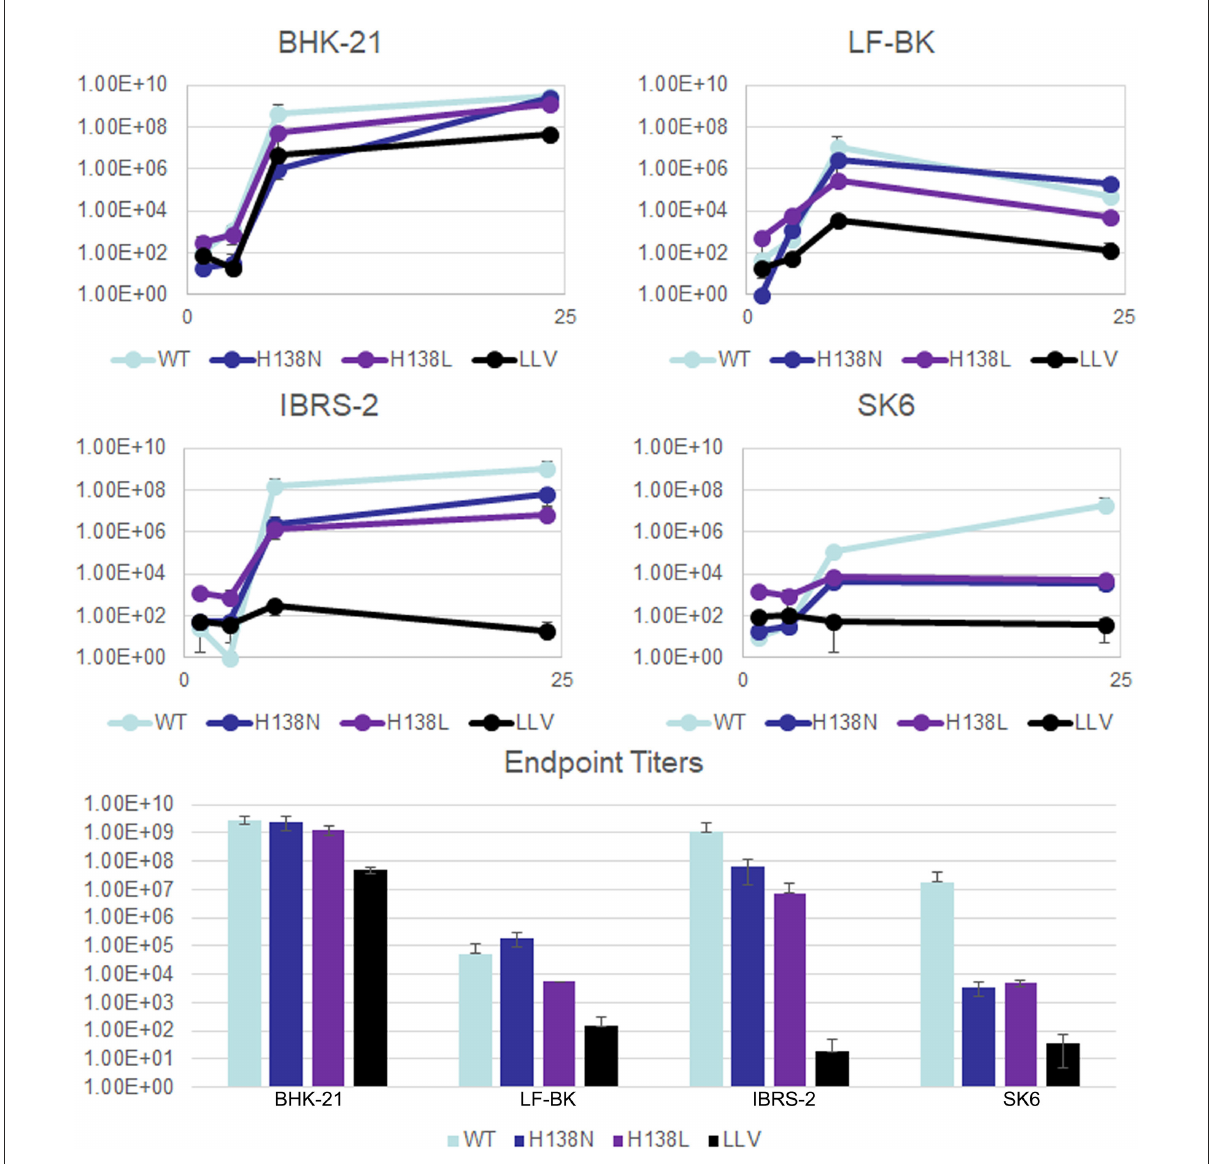
FIGURE2 Growth kinetics for A12-L H138 mutants. Growth curves on BHK-21, LF-BK, IBRS2, or SK6 cells. Cells were infected with FDMV A12 wild type (WT), FMDV A12 leaderless (LLV), and FMDV A12-L H138 mutants (H138N and H138L) at MOI = 10. After 1h, unabsorbed virus was removed by washing with 150mM NaCl, 20mM MES pH = 5.5 followed by addition of complete media. Samples were taken at 1, 3, 6 and 24 hpi and virus titers were determined by log10 TCID50 on BHK-21 cells.